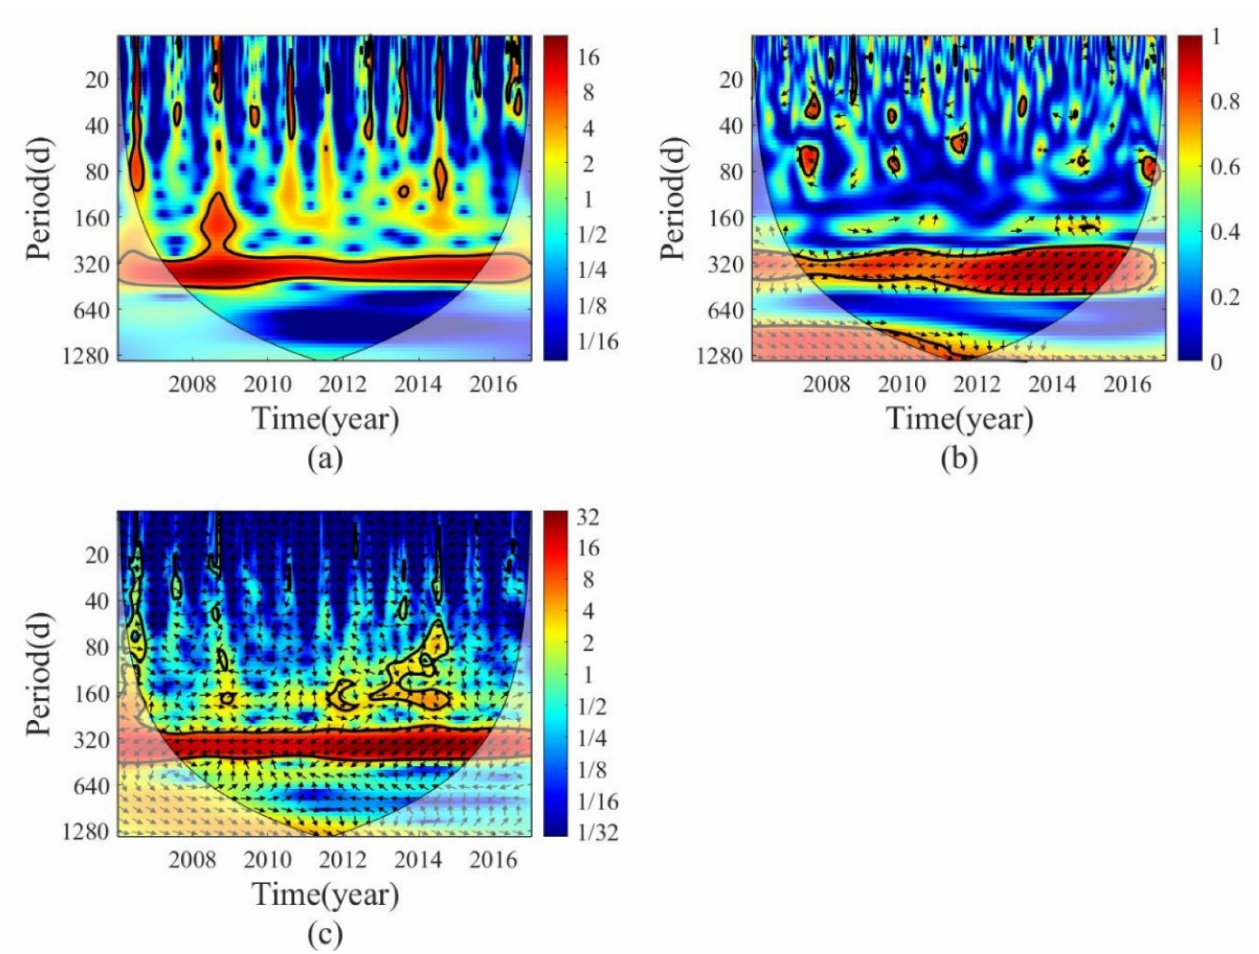
Figure 3. The results of wavelet analysis for a case: ( a ) Continuous wavelet power spectrum; ( b ) Cross wavelet coherence spectrum; ( c ) Cross wavelet power